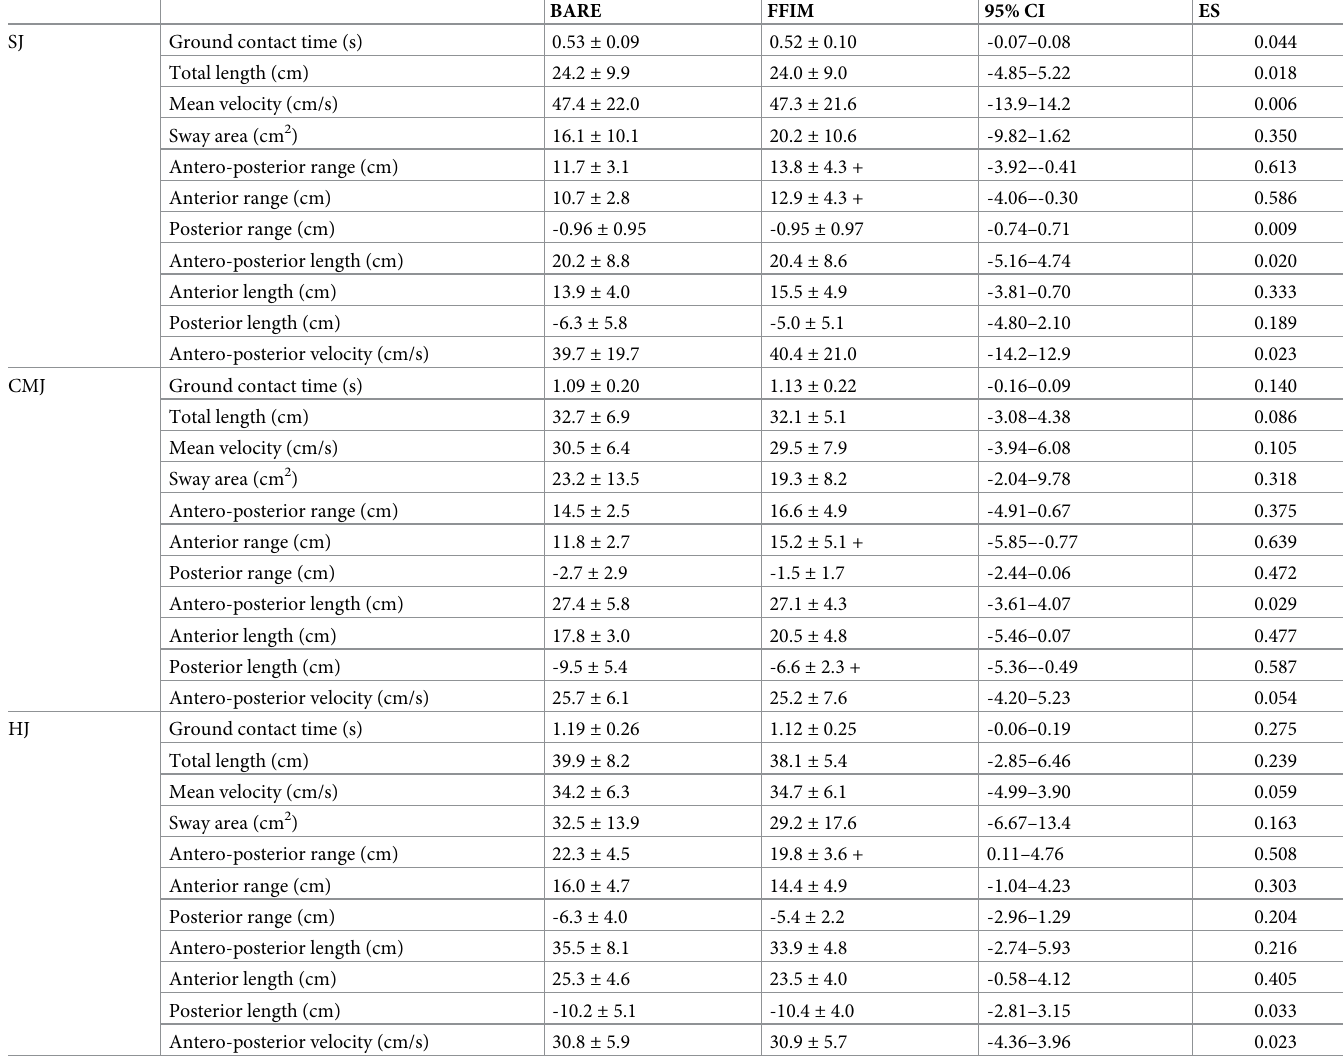
Table 3. Comparison of the centre of pressure (COP) related variables during the take-off phase of the squat jump (SJ), countermovement jump (CMJ) and hori- zontal jump (HJ) under barefoot (BARE) and forefoot immobilisation (FFIM) conditions.